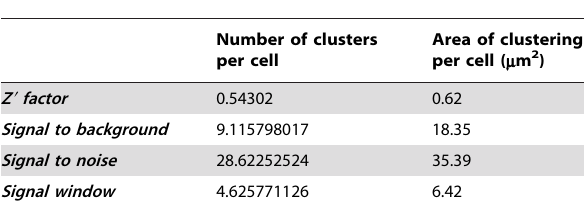
Table 1. Evaluation of assay